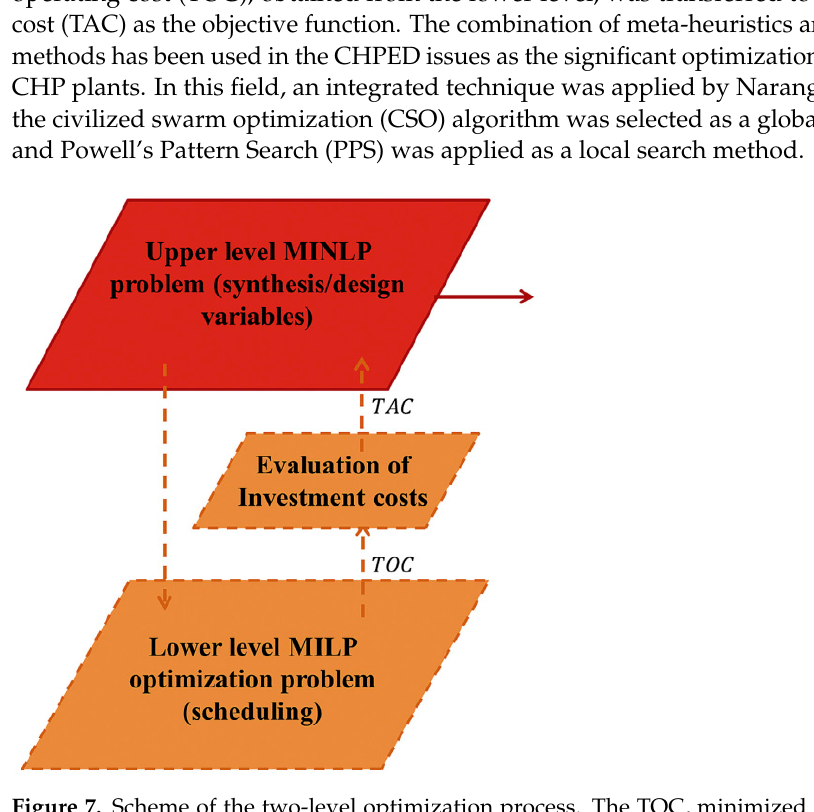
transferred to the TAC, minimized at the upper level [131].